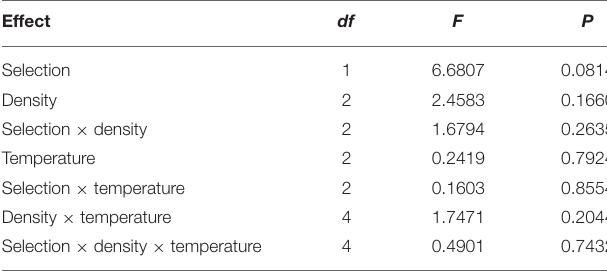
TABLE 3 | Results of ANOVA on CV (coefficient of variation) of development time across